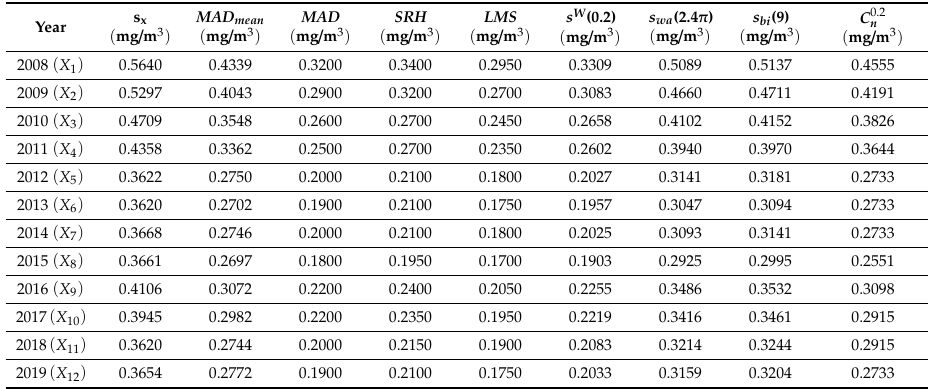
Table 4. Point estimates of